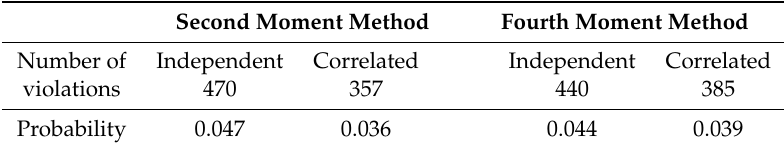
Table 2. The number of constraint violations from 10,000 Monte Carlo simulations, where the robust inequality constraints are approximated by the second and fourth moment methods for process designs with independent and correlated